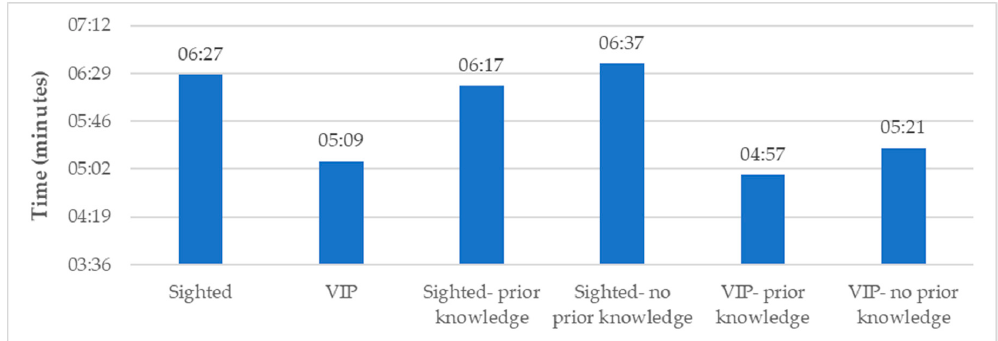
Figure 7. Efficiency in navigation task.